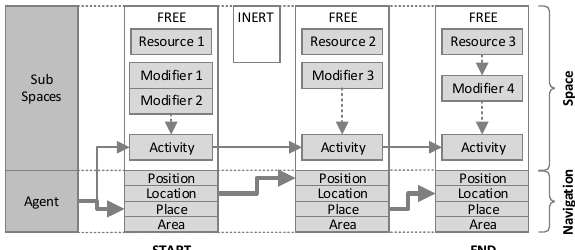
Figure 7. Position, Location, Place and Area built into the framework.